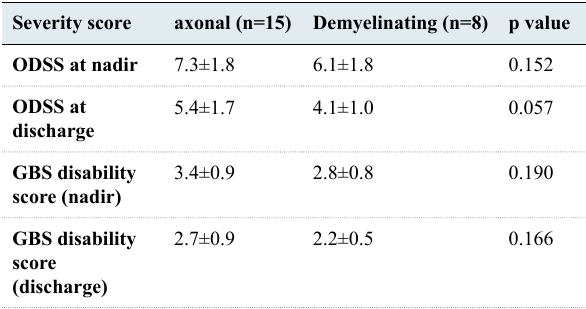
Table 2: Clinical Severity according to ODSS and GBS